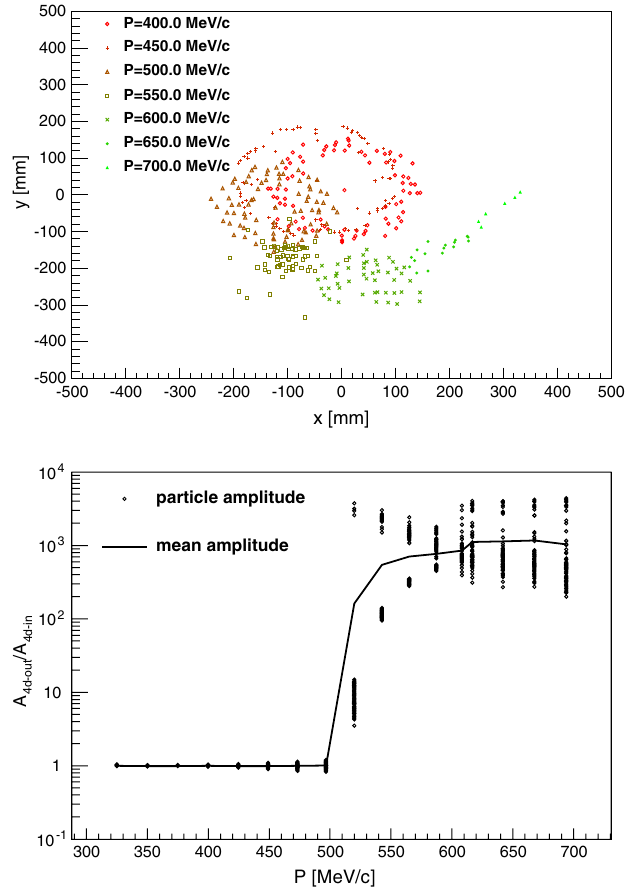
FIG. 1. (top) x - y projection and (bottom) fractional change in transverse amplitude of a shell of muons after transport through the chicane system for a variety of momenta. The muons were created on the surface of a hyperellipsoid in ð x; p x ; y; p y Þ space at intervals of 25 MeV =c total momentum. The surface was chosen at each momentum to be constant in the 1.5 T field with 4D transverse amplitude of 50 mm. Simulation in MAUS 0.3.1